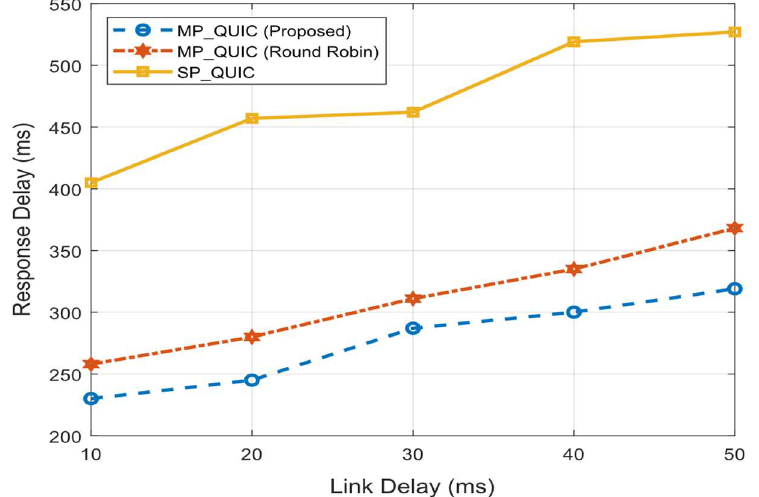
Figure 9. Response delays for different link delays when all pakcets have the same priority.